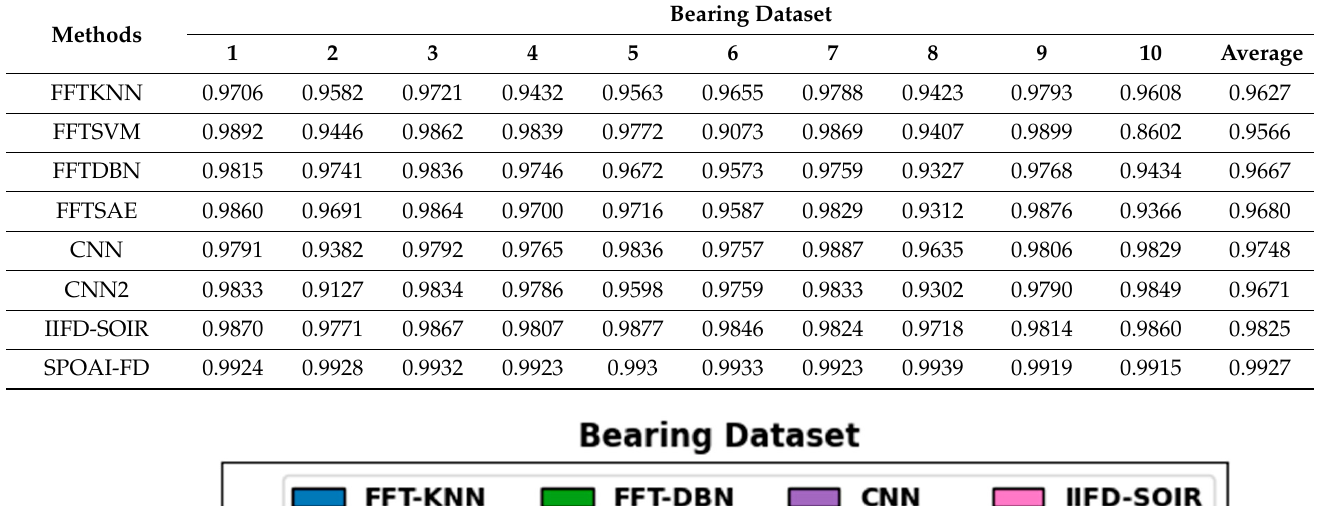
Table 5. Analytical results of Each Fault Class of different methods on bearing dataset.